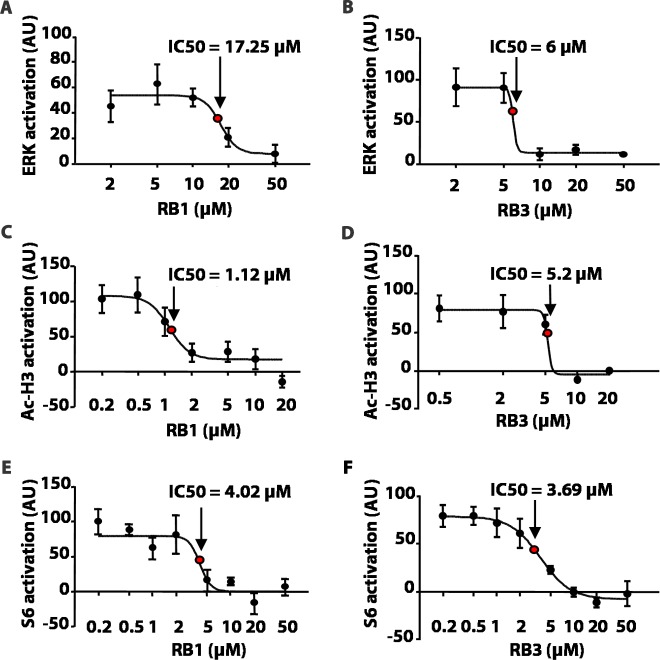
RB1 and RB3 inhibit ERK, histone H3 and S6 ribosomal protein activation in an ex-vivo model of acute striatal slices in a dose-dependent manner.(A–F) Dose response curves of RB1 and RB3 for ERK, Ac-H3 and S6 activation. 200 μm thick striatal slices were freshly prepared from 2-month old mice and transferred into a perfusion chamber for 1 hr at 32°C. Slices were pre-treated with either different doses of peptides (RB1 and RB3) or scrambled controls (scramble RB1 or scramble RB3). After 1 hr, one group of slices for each condition was fixed in PFA 4% for 15 min, while another group was stimulated with glutamate 100 μM for 10 min prior to fixation. 18 μm cryo-sections were processed for immunohistochemistry with anti-phospho p44/p42 MAP kinase (Thr202/Tyr204) or for immunofluorescence co-labelling the slices with anti-phospho (Ser10) - acetyl (Lys14) H3 or anti-phospho S6 (Ser235/236) and the neuronal marker NeuN. Neuronal quantification was performed with ImageJ software by counting the number of phospho-ERK positive cells and the number of phospho-Ac-H3 or phospho-S6 among NeuN positive neurons in each slice. The level of activation is expressed on the Y-axis as arbitrary units (AU). Doses are reported in a logarithmic scale (Log10) on the X-axis. The IC50 was calculated for each specific response using GraphPad Prism software.